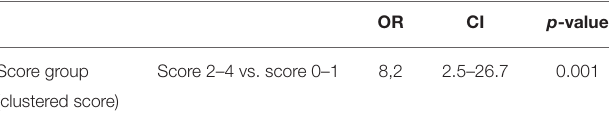
TABLE 8 | Univariate logistic regression evaluating the association between the score groups and lymph node metastasis in the N + plus N0 with > 12 lymph nodes